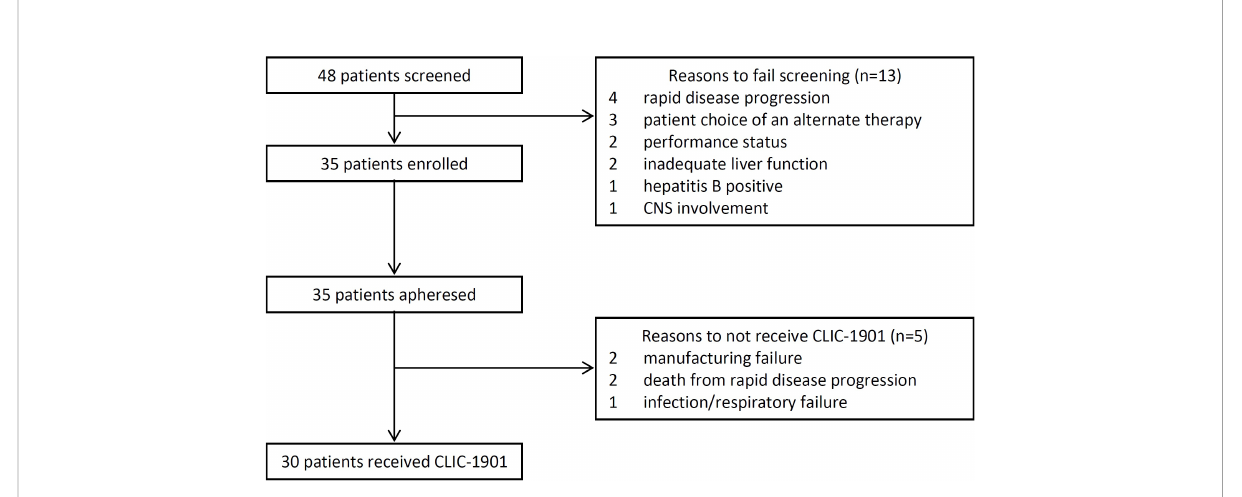
FIGURE 1 Patient Flow